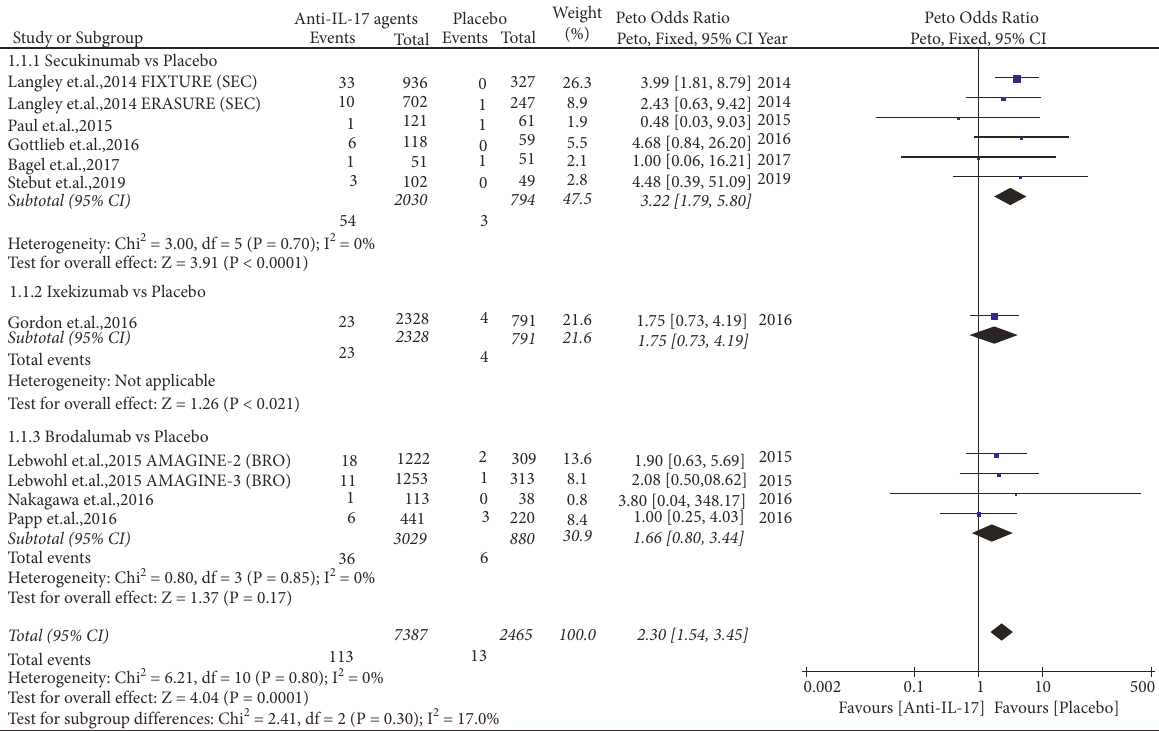
Figure 2: Forest plot of pooled data regarding Candida infections between anti-interleukin (IL)-17 agents and placebos. CI, confidence